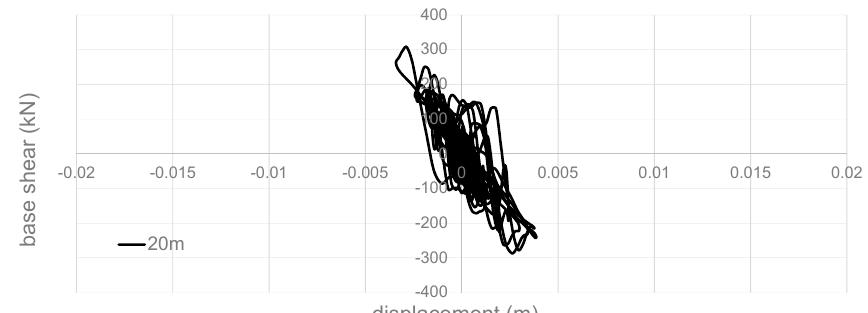
Figure 19. Top displacement time histories. Table 6. Maximum top displacements. Models